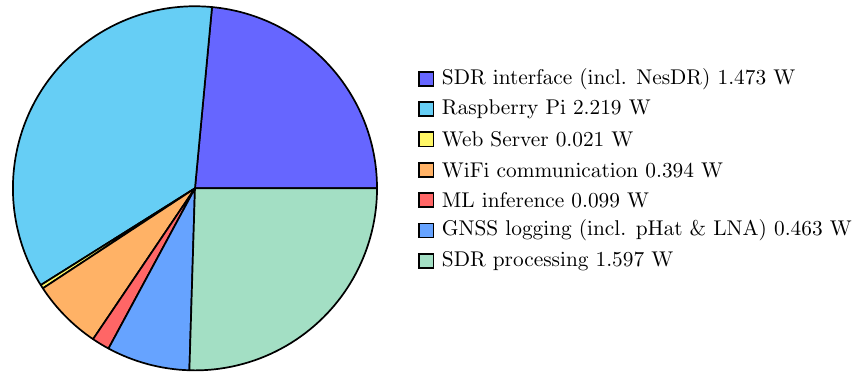
Figure 5. Average power consumption of the different parts of the monitoring station, in